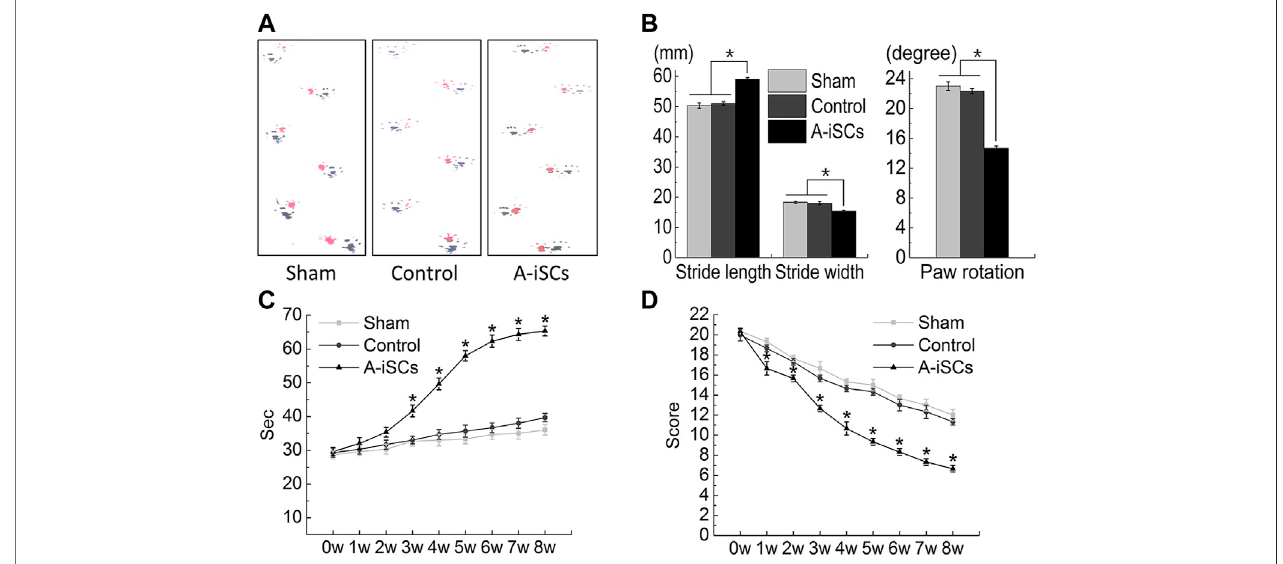
FIGURE6| Behavioralimprovementfollowingthetransplantation ofA-iSCsintoMCAOmice (A – D) . (A,B) Theresultsofthefootprintanalyses andgripwalktestof the mice with A-iSCs transplantation in comparison to those in sham and control groups at 8 weeks. (C) Rotarod testing of the mice with A-iSCs transplantation in comparison to those in sham and control groups over 8 weeks. (D) Modi fi ed neurological severity score (mNSS) testing of the mice with A-iSCs transplantation in comparison to those in sham and control groups over 8 weeks. The data are presented as mean ± SD. * p < 0.05.